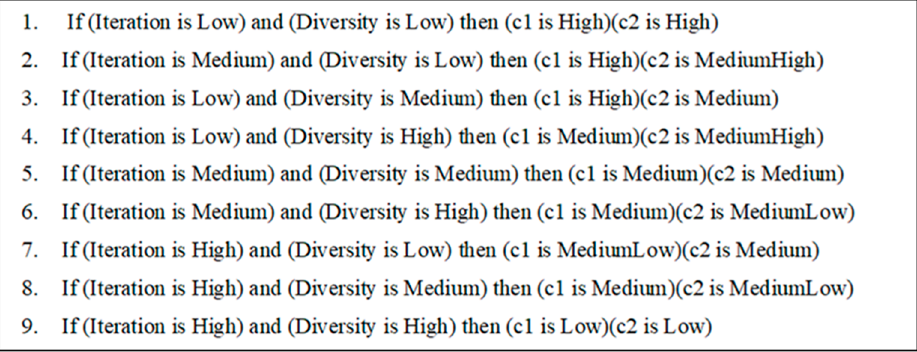
Figure 8. Fuzzy system proposed for the dynamic parameter adaptation designed with Gaussian MFs. 4.1. Design of the Interval Type-2 Fuzzy Systems To compare results and analyze which obtains a better performance of the BSA, it is decided to take the structure and rules and implement them in the interval type-2 fuzzy systems (IT2FS). In Figure 9, the design used for the IT2FS is presented; it is worth men- tioning that it manually adjusts the footprint of uncertainty. The comparison carried out has the objective of analyzing the performance and comparing the results with the type-1 fuzzy system since, as is known, the membership functions of IT2FS are characterized by upper and lower membership functions, where the interval between these two can have a better performance than the type-1 fuzzy system since, due to the nature of IT2FS, it can handle a higher degree of uncertainty.